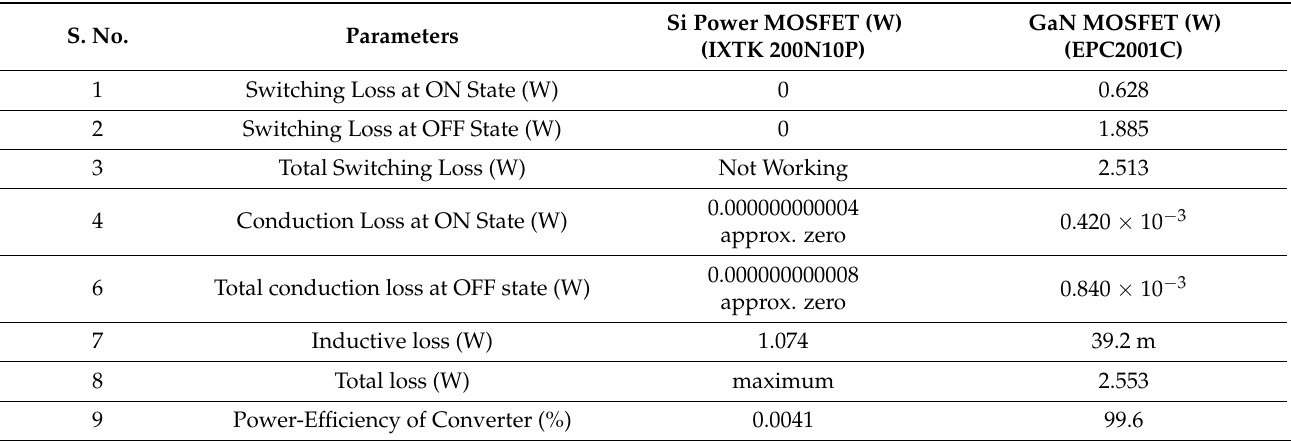
Table 2. Losses and efficiency calculation